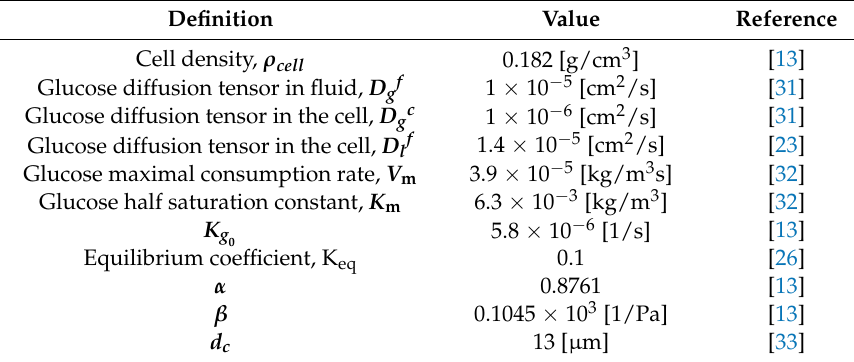
Table 1. Numerical values of the model parameters used in the